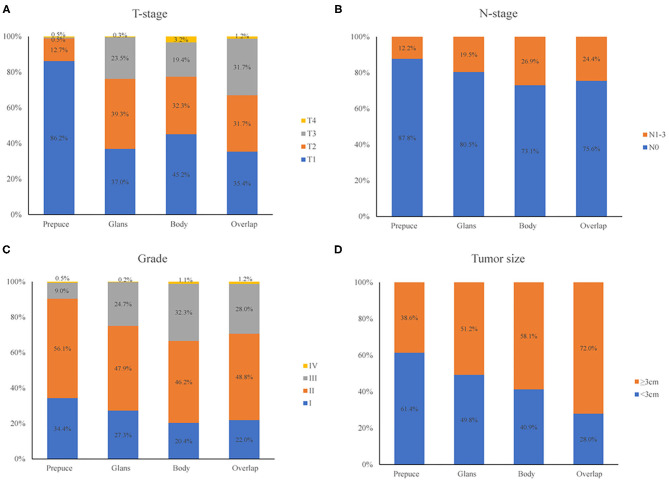
Comparison of oncology features of patients with different primary tumor site. T-stage (A), N-stage (B), tumor grade (C), and tumor size (D) had different distribution in patients with different primary tumor site (all p < 0.001).